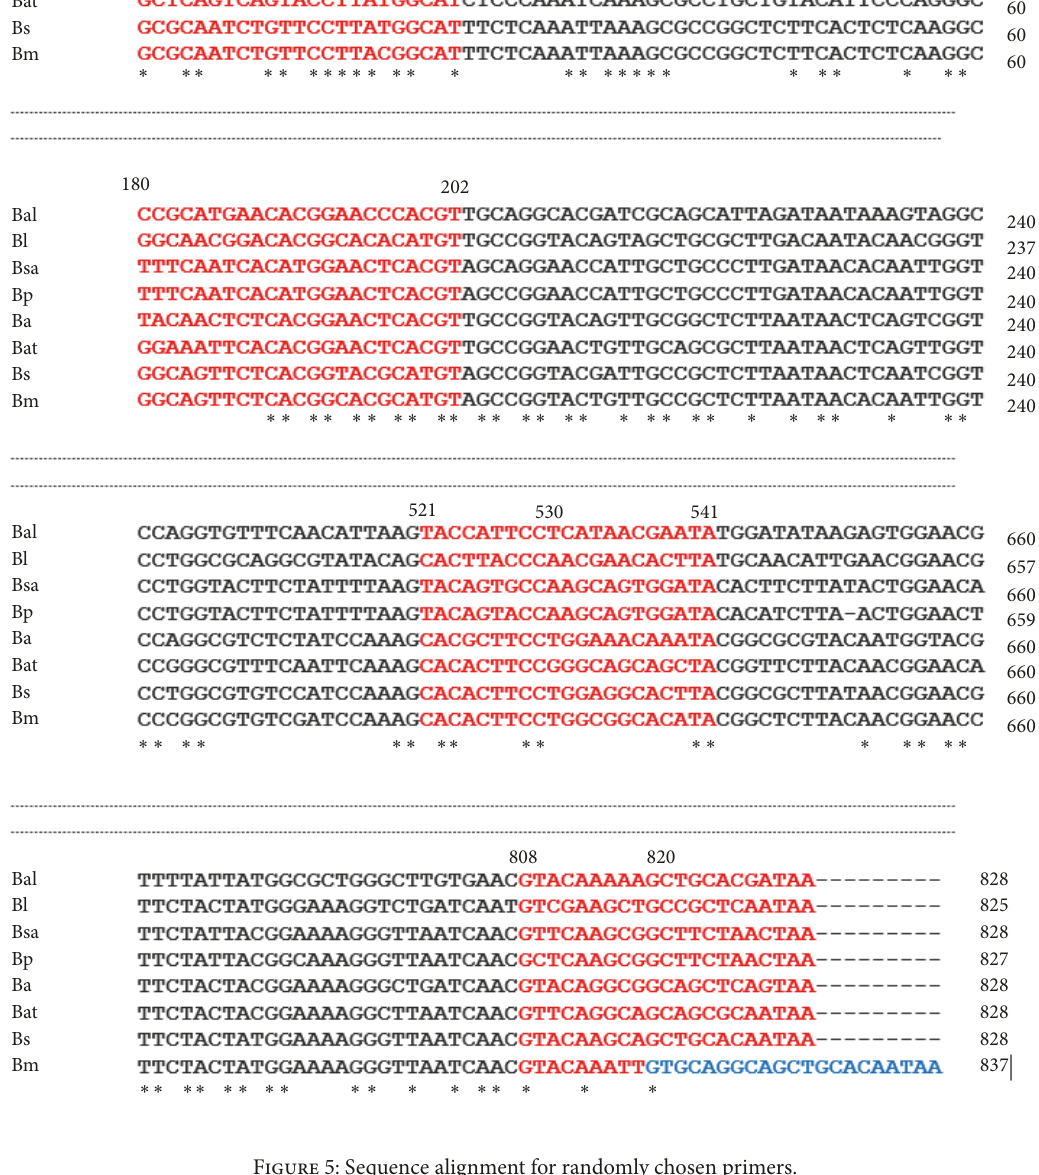
Figure 5: Sequence alignment for randomly chosen